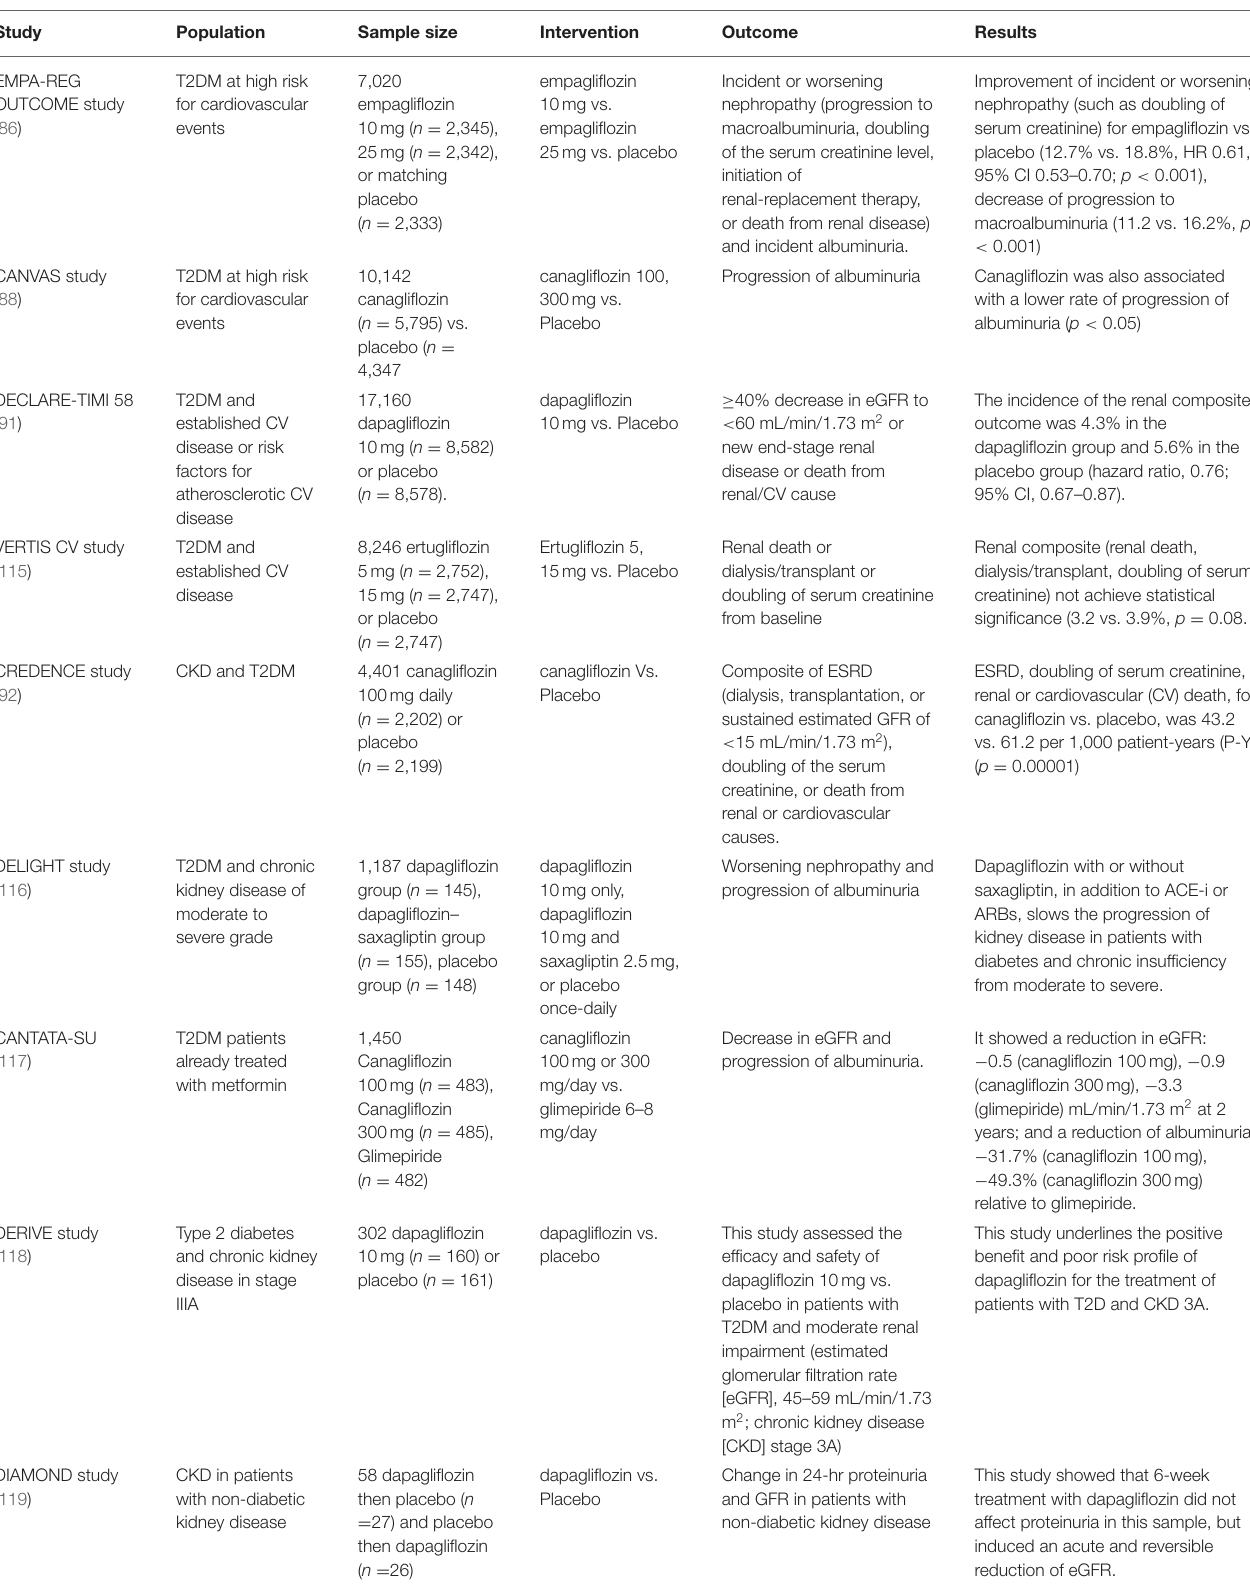
TABLE 1 | Studies comparing risk renal outcomes among patients with CKD treated with